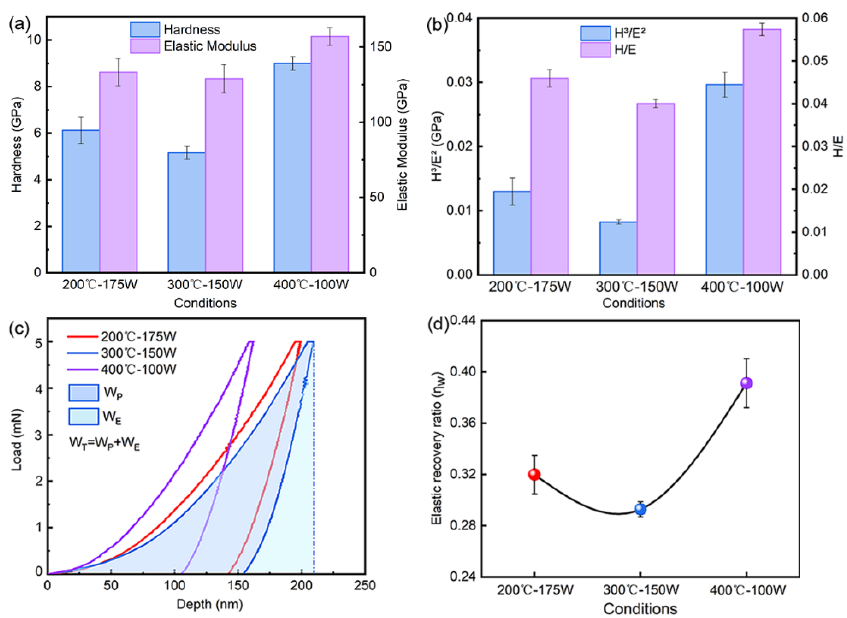
Figure 7. ( a ) H and E, ( b ) H/E and H 3 /E 2 , ( c ) load–depth curves, and ( d ) elastic recovery ratio of Ta coatings.